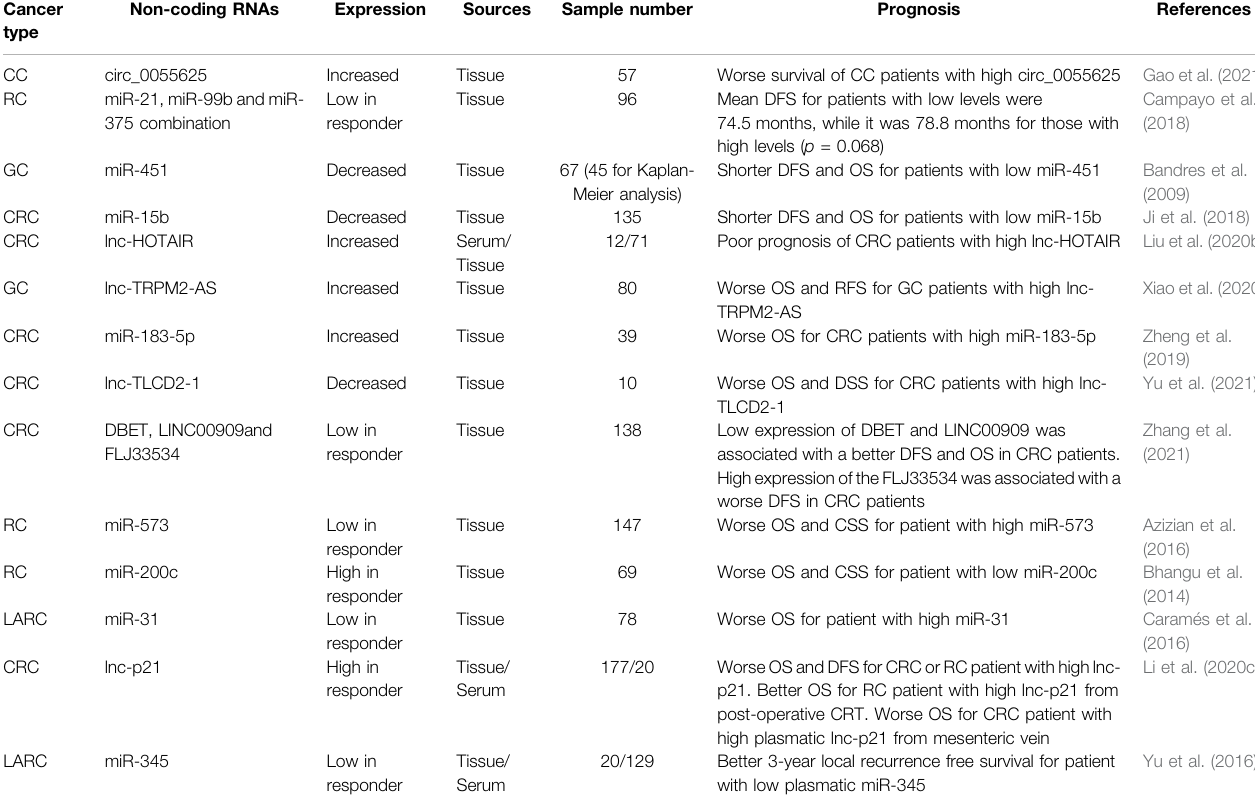
TABLE 4 | The clinical application of non-coding RNAs in gastrointestinal carcinoma. Cancer